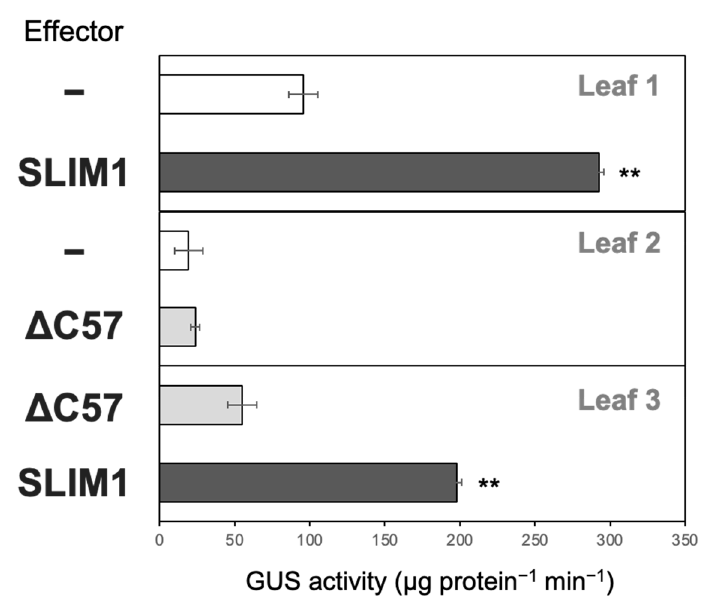
Figure 6. Transactivation of SHM7/MSA1 promoter by full-length and C-terminal 57 aa truncated SLIM1. GUS activity was measured in transiently transformed Nicotiana benthamiana leaves incubated for 72 h after the infiltration with the reporter ( SHM7/MSA1 promoter-GUS) or the combination of the reporter and effectors (SLIM1 or Δ C57). The uidA gene in the reporter constructs was driven by the SHM7/MSA1 promoter (569 bp upstream of ATG), and the effector expressions were driven by the CaMV 35S promoter. The mean values are indicated with error bars denoting SD ( n = 3). Asterisks indicate significant differences between the two combinations of reporter and effector transfected in each leaf (Student’s t -test; ** p < 0.01, * 0.01 ≤ p < 0.05).